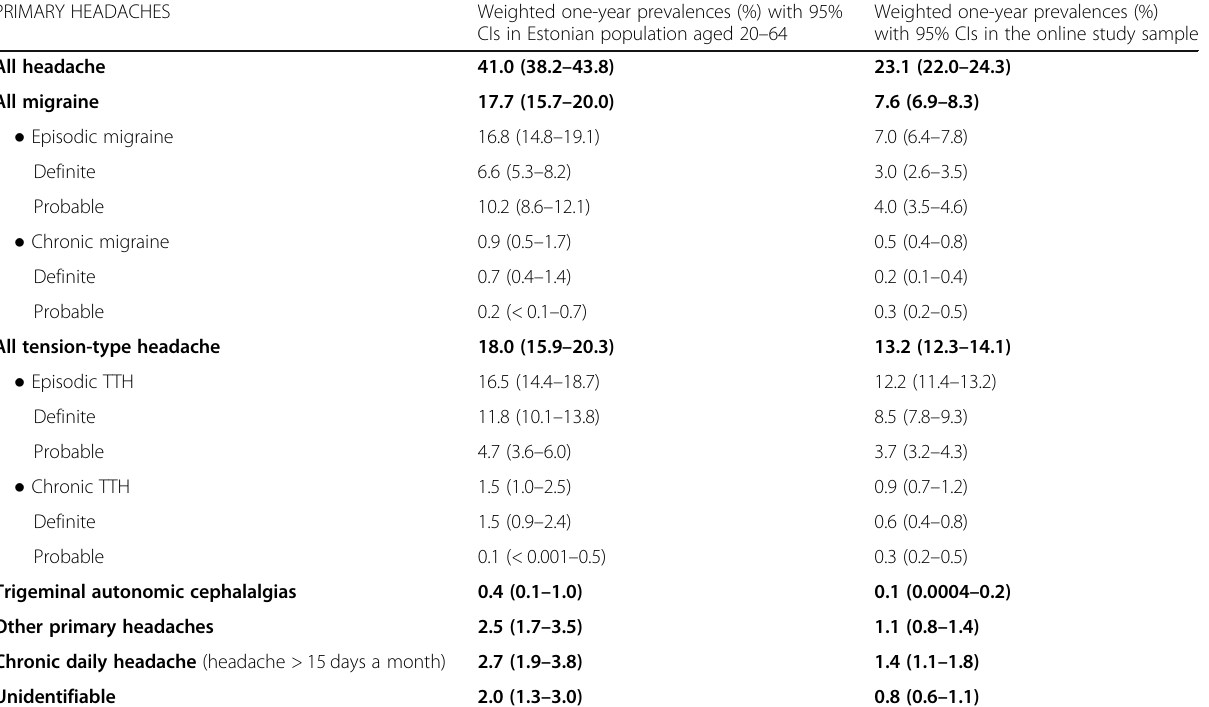
Table 3 Comparison of weighted one-year prevalences of primary headaches in Estonia [6] and in the online